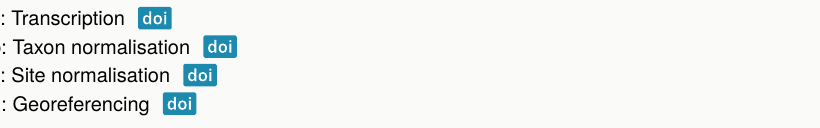
Transcription, mapping and georeferencing interfaces (from the fi rst version of the